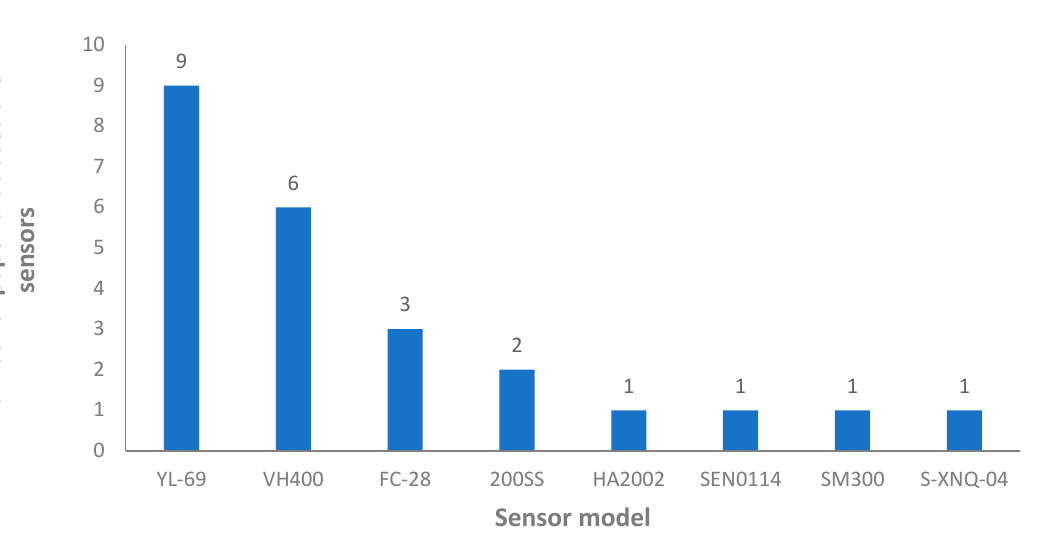
Figure 13. Number of papers that used di ff erent models of soil moisture sensors.